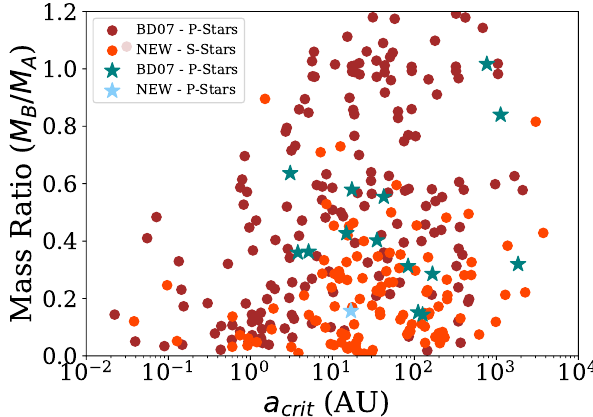
Figure 2. Critical semi-major axis vs. mass ratio ( M A / M B ) for the pairs in the Uniform Detectability (UD) sample with (stars) and without (filled circles) planetary companions. The new pairs not in BD07 are shown in light blue and orange, respectively.